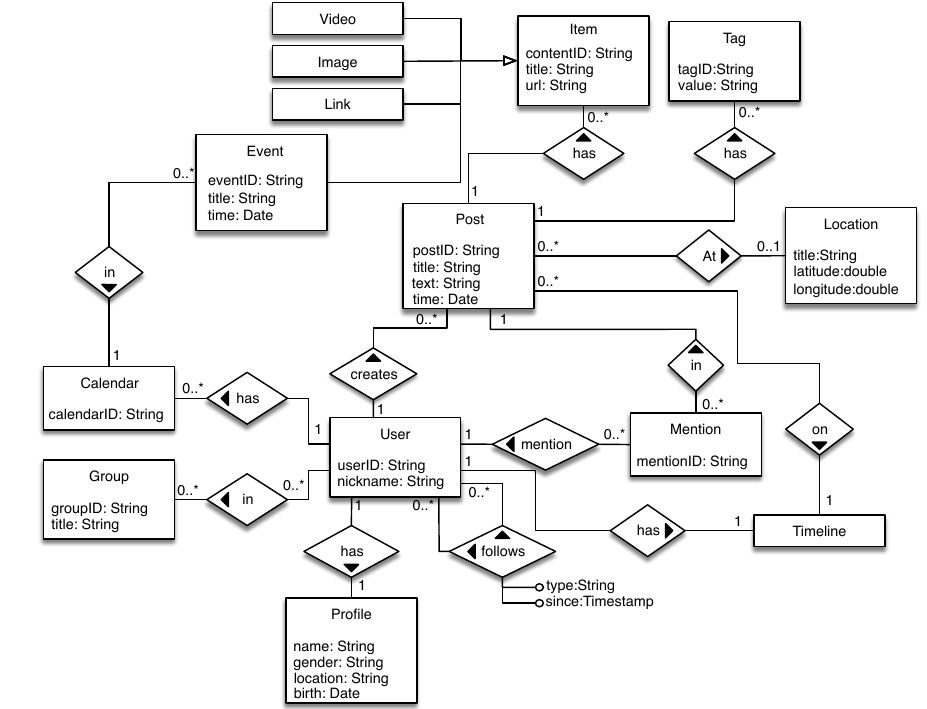
Figure 3. Conceptualization of social media